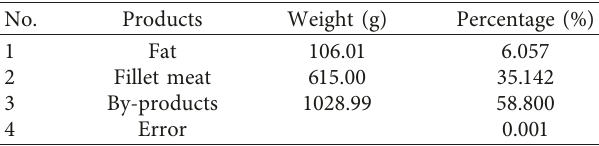
Table 1: Parts of catfish